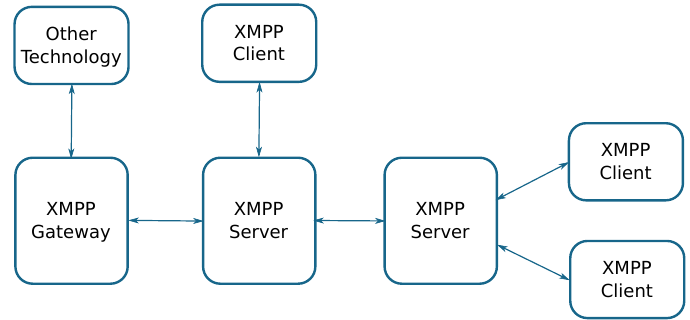
Figure 5. Basic XMPP (eXtensible Messaging and Presence Protocol)